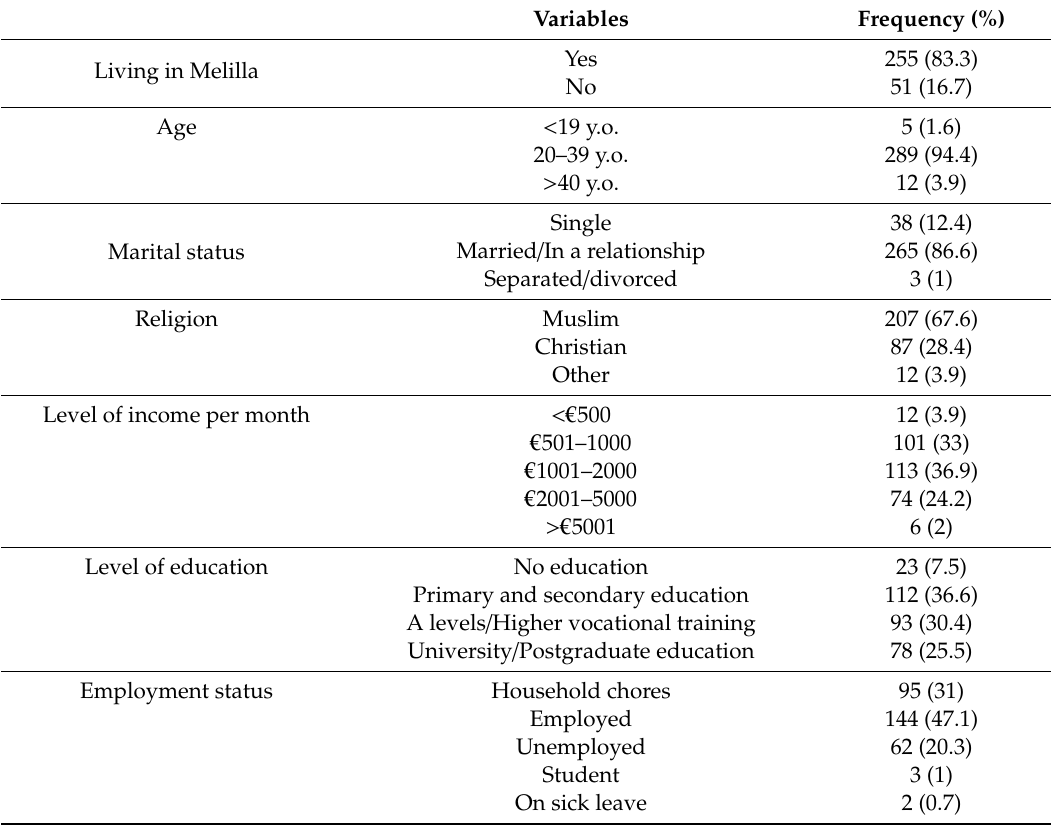
Table 3. Sociodemographic, lifestyle-related, and pregnancy-related variables (frequencies and percentages, N =